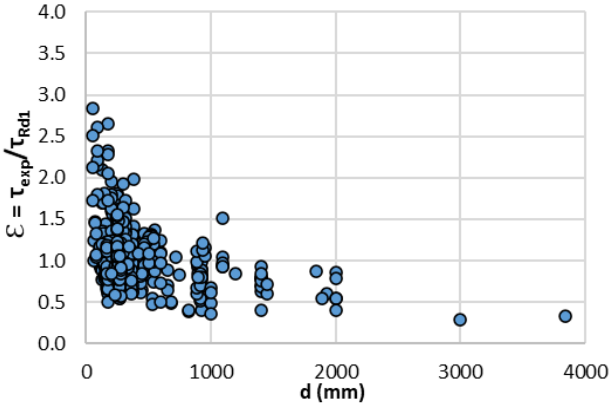
Figure 2. Impact of effective depth on model